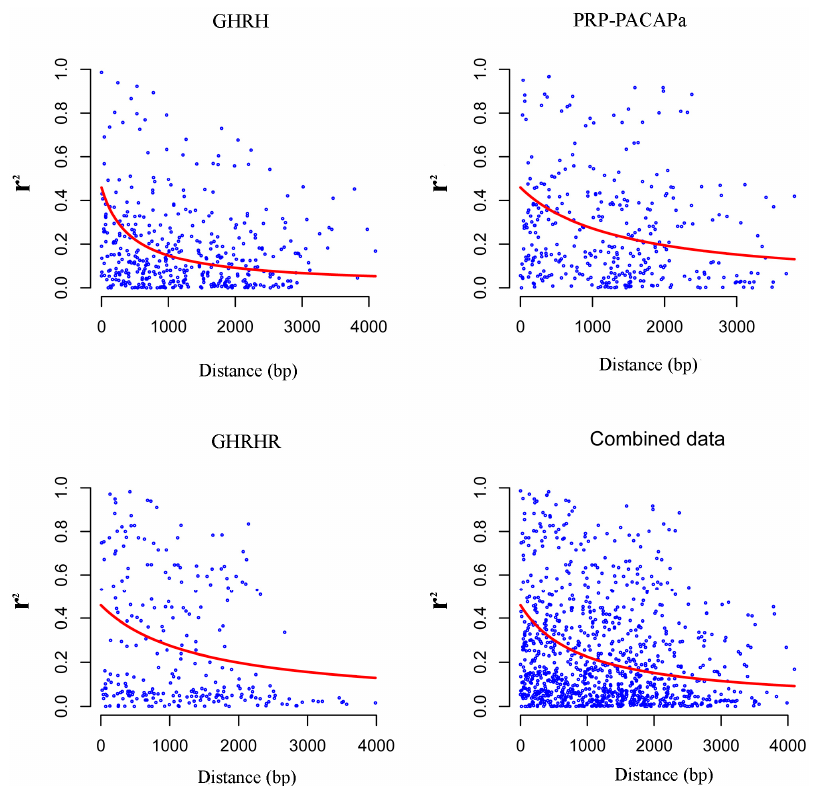
Figure 3. Illustration of the delay in LD for fragments of GHRH, PRP-PACAPa, GHRHR and for the combined data. r 2 points with distance are shown, and delay trends are fit to a mutation-recombination drift model.